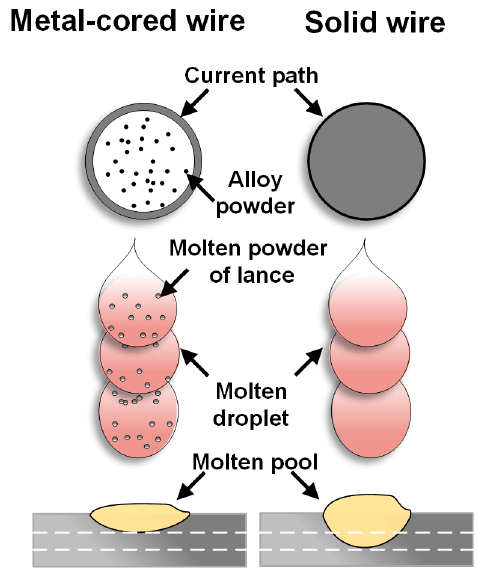
Figure 1. Comparison of the cross section and the metal transfer mode of a metal-cored wire and solid wire under short-circuit transfer mode.